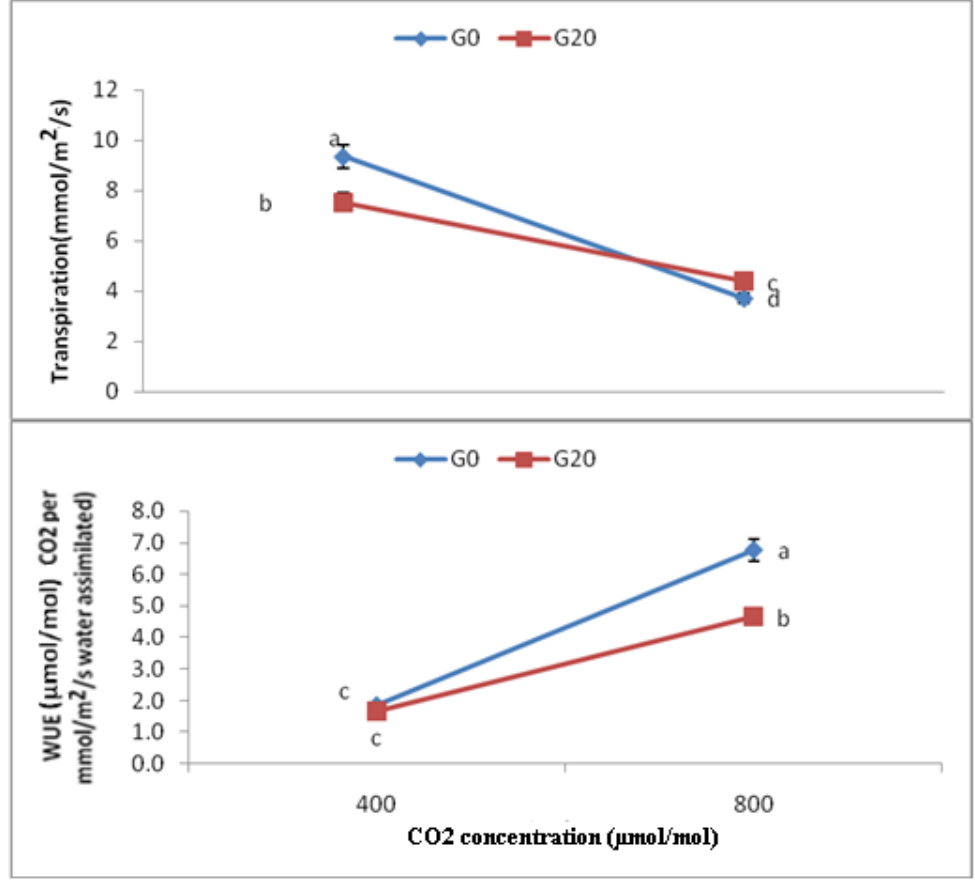
concentration on WUE and transpiration of plants 2